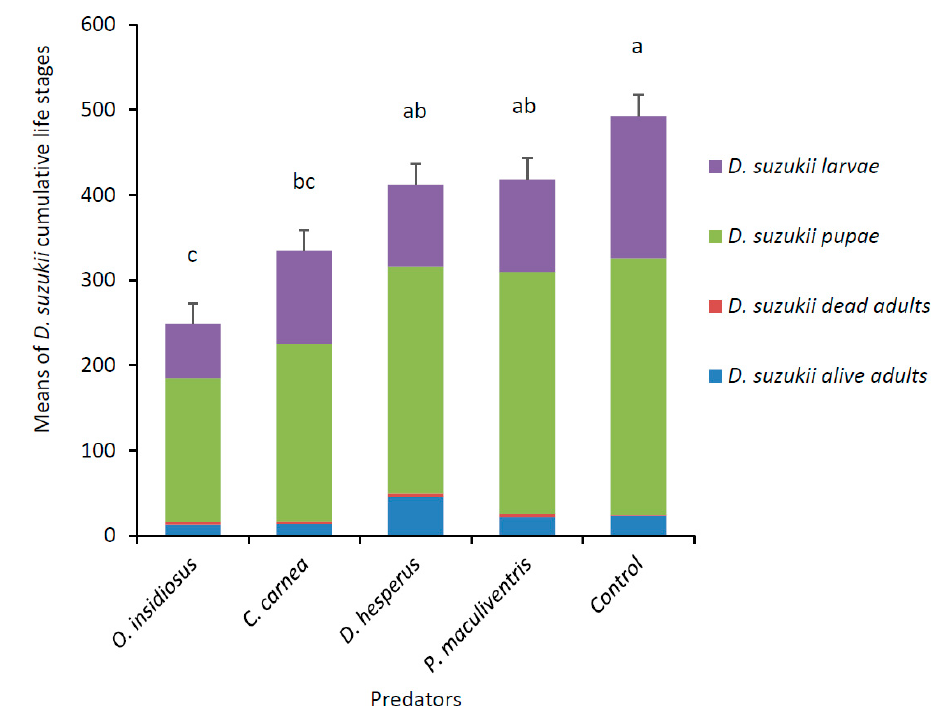
Figure 2. Means (± SE) of D. suzukii cumulative life stages (larvae, pupae, and dead and alive adults) recovered after 15 days when exposed to predators. Each arena ( n = 8 per predator species) contained five D. suzukii mated females and raspberries at the beginning of the experiment, with 18 predators added on day 3. Cumulative means with the same letter were not significantly different (Tukey’s HSD, p < 0.05).